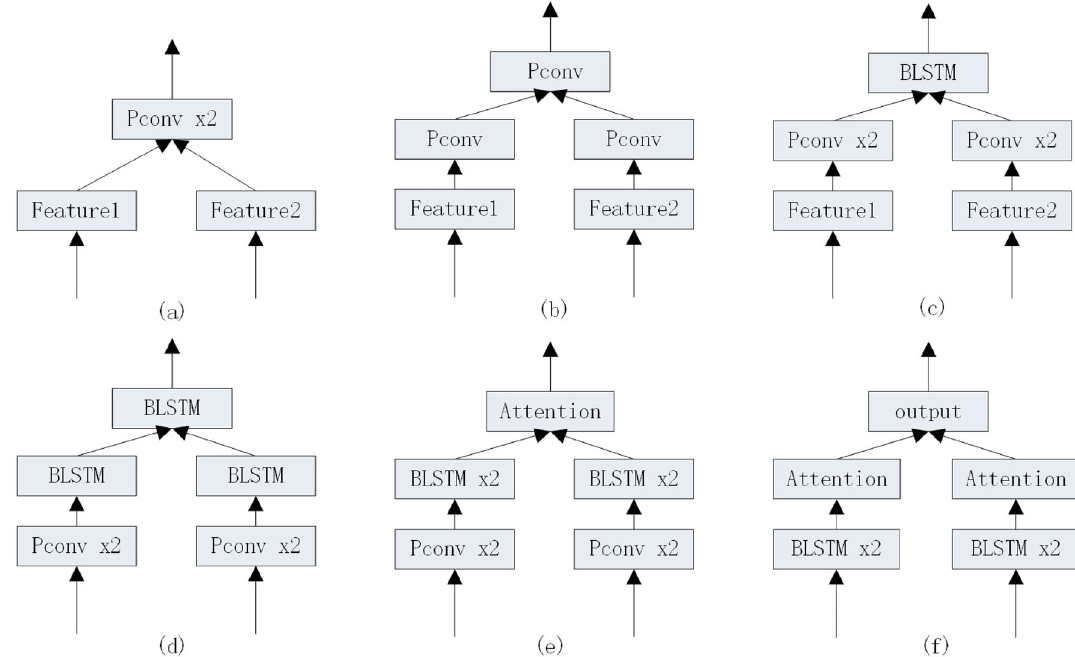
Fig. 6 The partial structure of different fusion methods Table 5 Performance results of different fusion methods